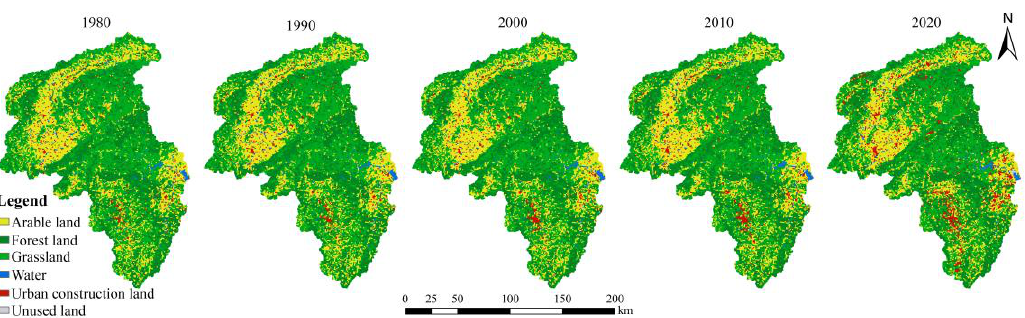
Figure 2. Spatial pattern of land-use changes in the upper Hutuo River Basin from 1980 to 2020.